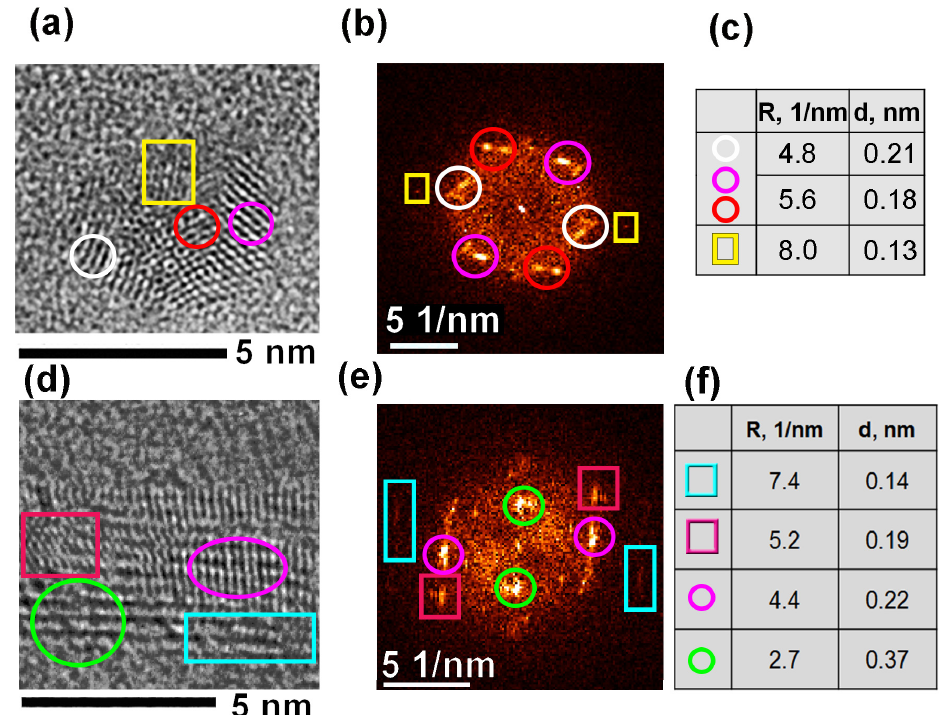
Figure 5. Enlarged fragments of the HRTEM images for CVD FLG films irradiated with 167 ( a ) and 26 ( d ) MeV Xe ions; ( b ) and ( e ) are their fast Fourier transformation (FFT) patterns, respectively. Some bright spots, labeled by colored circles and squares, are described in the tables ( c ) and ( f ). The irradiation doses were 5 × 10 11 and 1 × 10 11 ion/cm 2 for ( a ) and ( d ), respectively. There are some planes with a distance of ~0.37 nm between them in the bottom part of Figure 5d. They are supposed to be vertically oriented and expanded graphene layers. axis). The interlayer distance for the shell of the observed structure (along the white